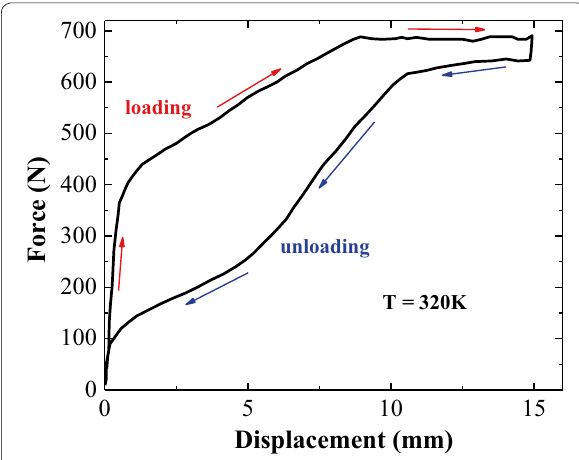
Figure 8 Shape changing process of SMA bar in a loading-unloading-heating cycle